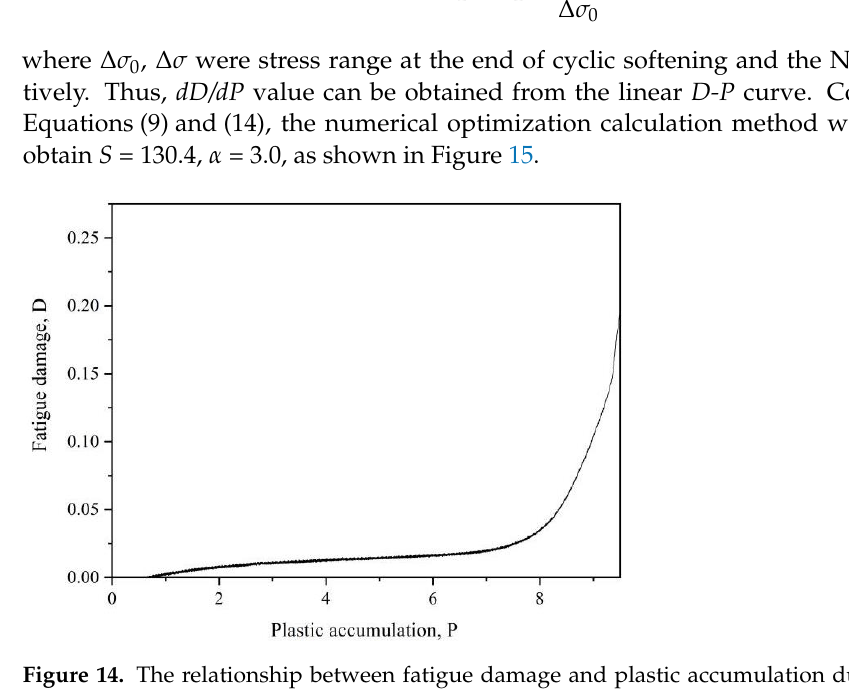
Figure 15 . Fitting of damage mechanics parameters for low cycle fatigue life of TC21 titanium alloy. 3.3.3. Fatigue Damage Model Verification and Discussion In order to verify the model, the damage of stress fatigue is evaluated by formula: / E E D * − = 1 (15) where E was the elastic modulus for the undamaged sample, and E* was the elastic modulus for the damaged sample. The elastic modulus after fatigue damage under 950 MPa stress were measured to characterize fatigue damage, as shown in Figure 16. Fatigue damage predicted by this model was consistent with experimental data.